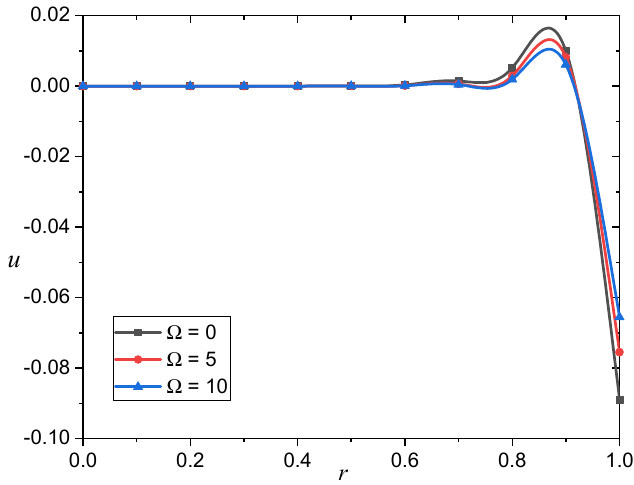
Figure 7. The temperature variation (cid:2016) for different rotation parameter Ω .